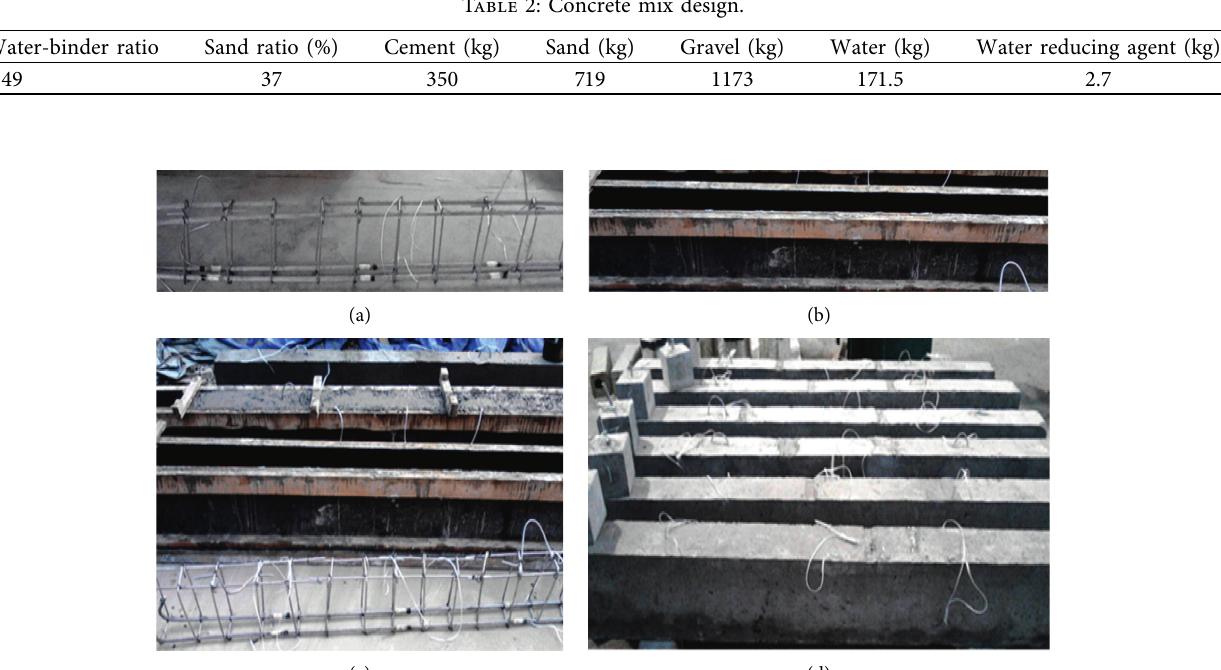
Figure 2: Photographs of the specimens: (a) reinforcement cage; (b) formwork; (c) production process; (d) cured specimens.